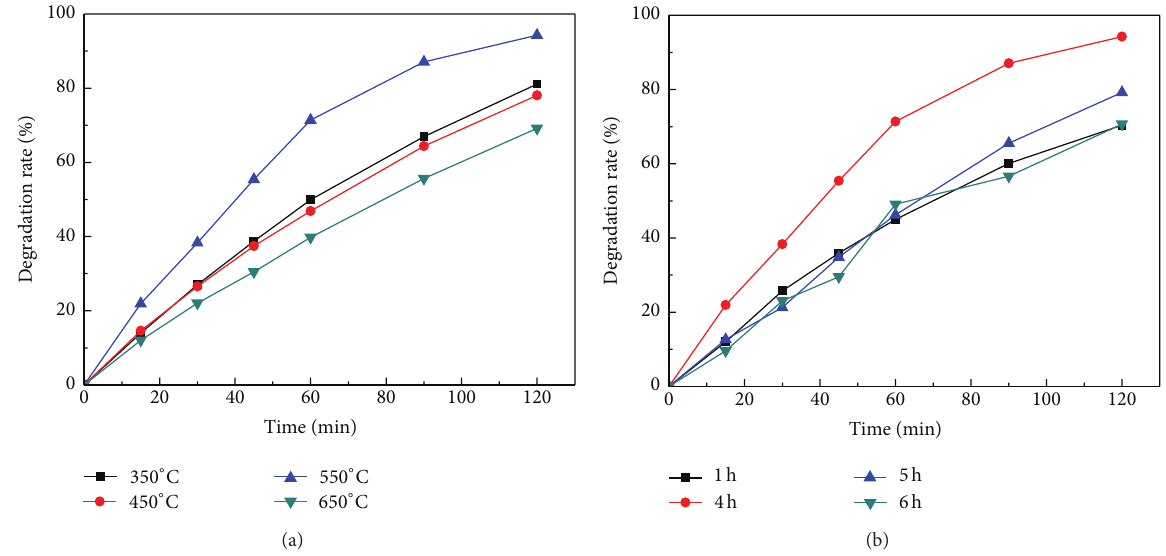
Figure 6: Electrocatalytic performance of samples: (a) samples calcined at different temperatures for 4h; (b) samples calcined at 550 ∘ C for different time.